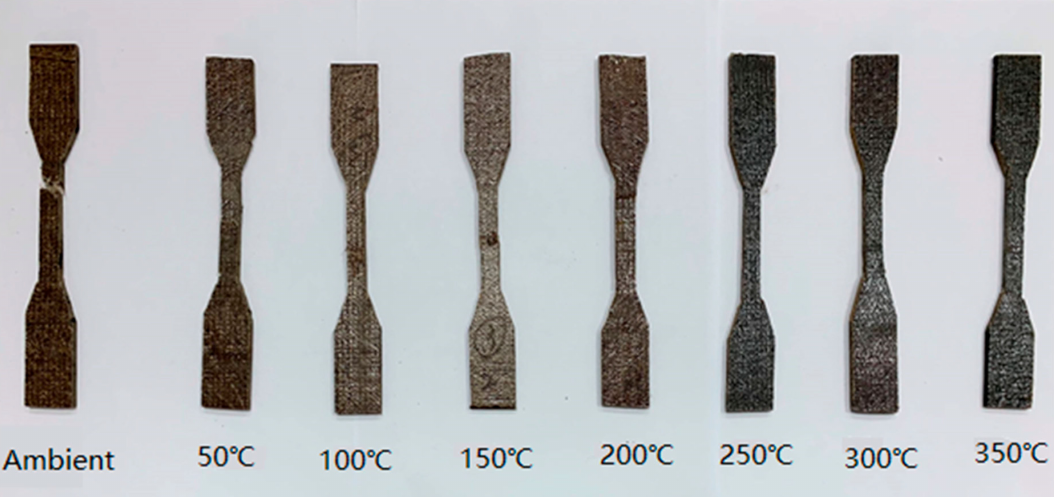
Figure 4. Specimens after experiencing elevated temperatures and tensile loading.